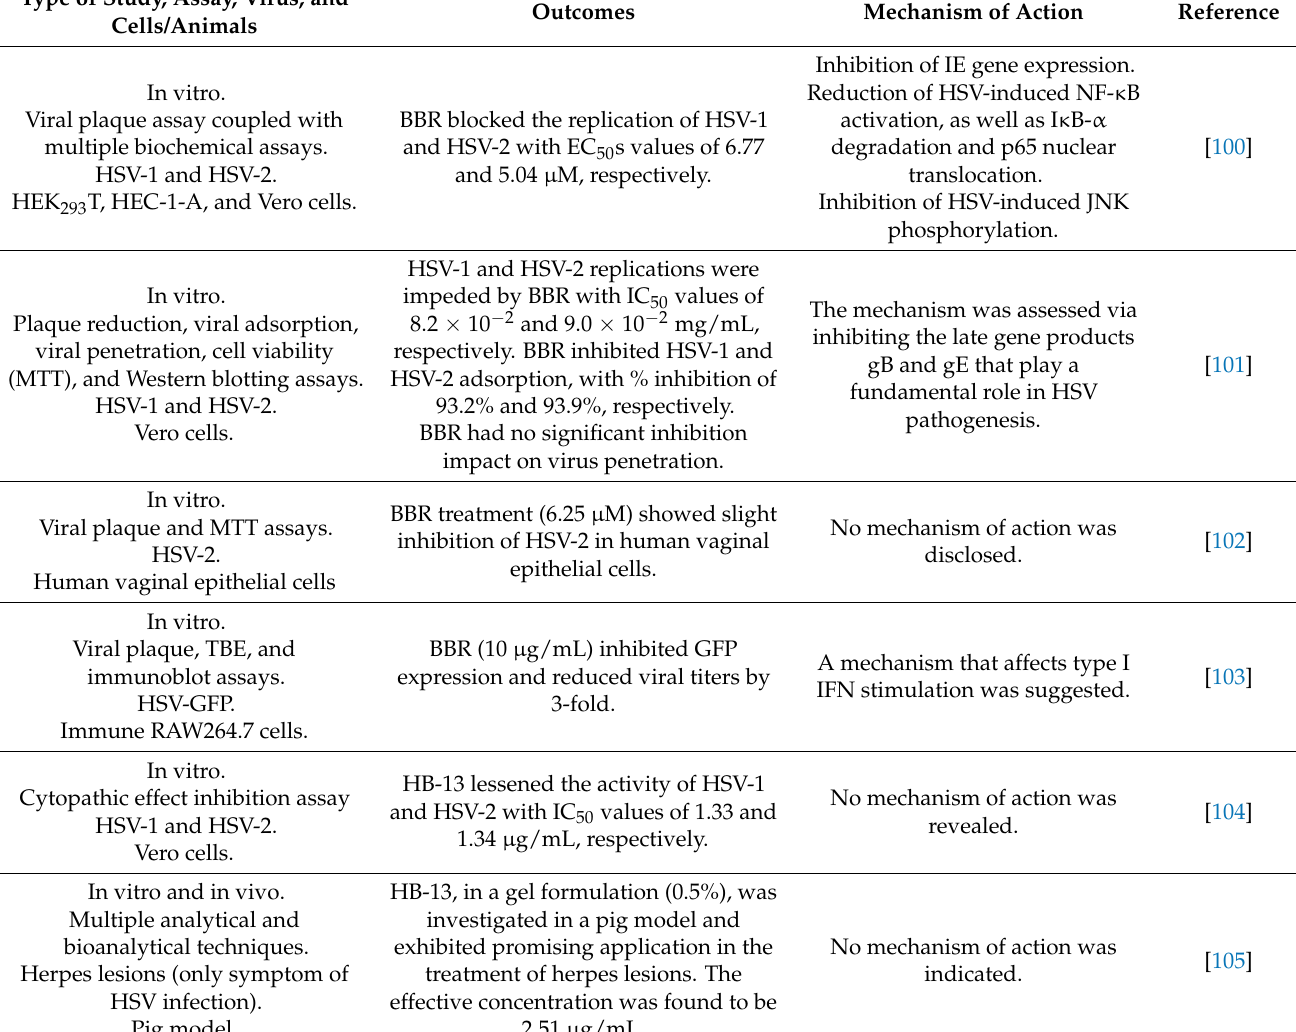
Table 2. Antiviral effects of berberine and its derivatives against herpes simplex virus. Type of Study, Assay, Virus, and